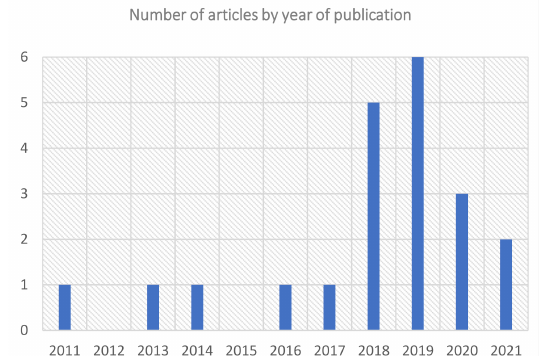
Figure 3. Number of articles by year of publication (May 2021).